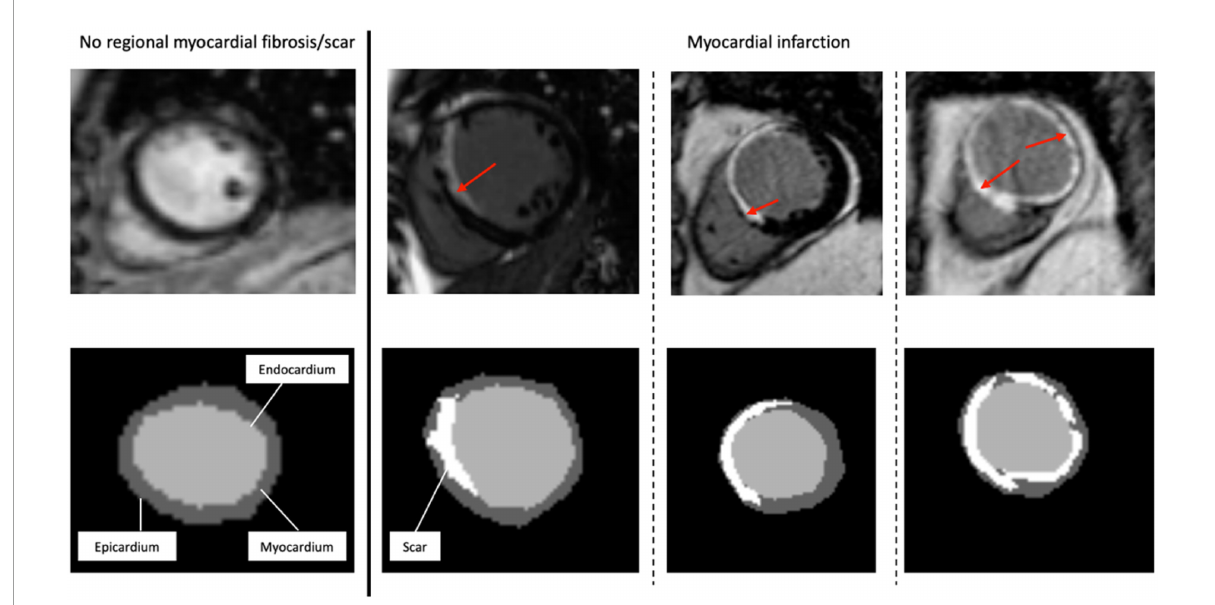
FIGURE1 Representative short-axis late gadolinium enhancement-cardiac magnetic resonance images (LGE-CMR) of various possible locations and extents of myocardial scar. The top images are the original LGE images, with the red arrows indicating the distribution of LGE (scar) in the LV wall segments. At the bottom are the segmentation masks (expert manual contouring) with the scarred regions in